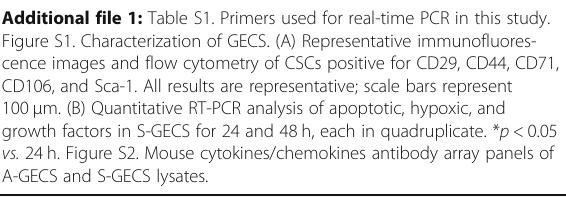
vs. 24 h. Figure S2. Mouse cytokines/chemokines antibody array panels of A-GECS and S-GECS